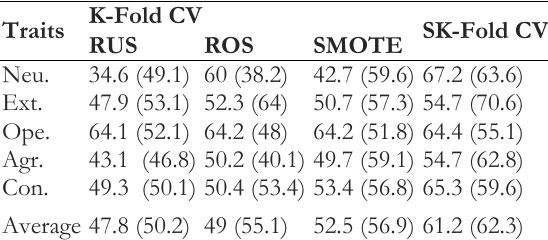
Table 4. Comparison of personality classification by K-Fold CV and SK-Fold CV methods in UTS